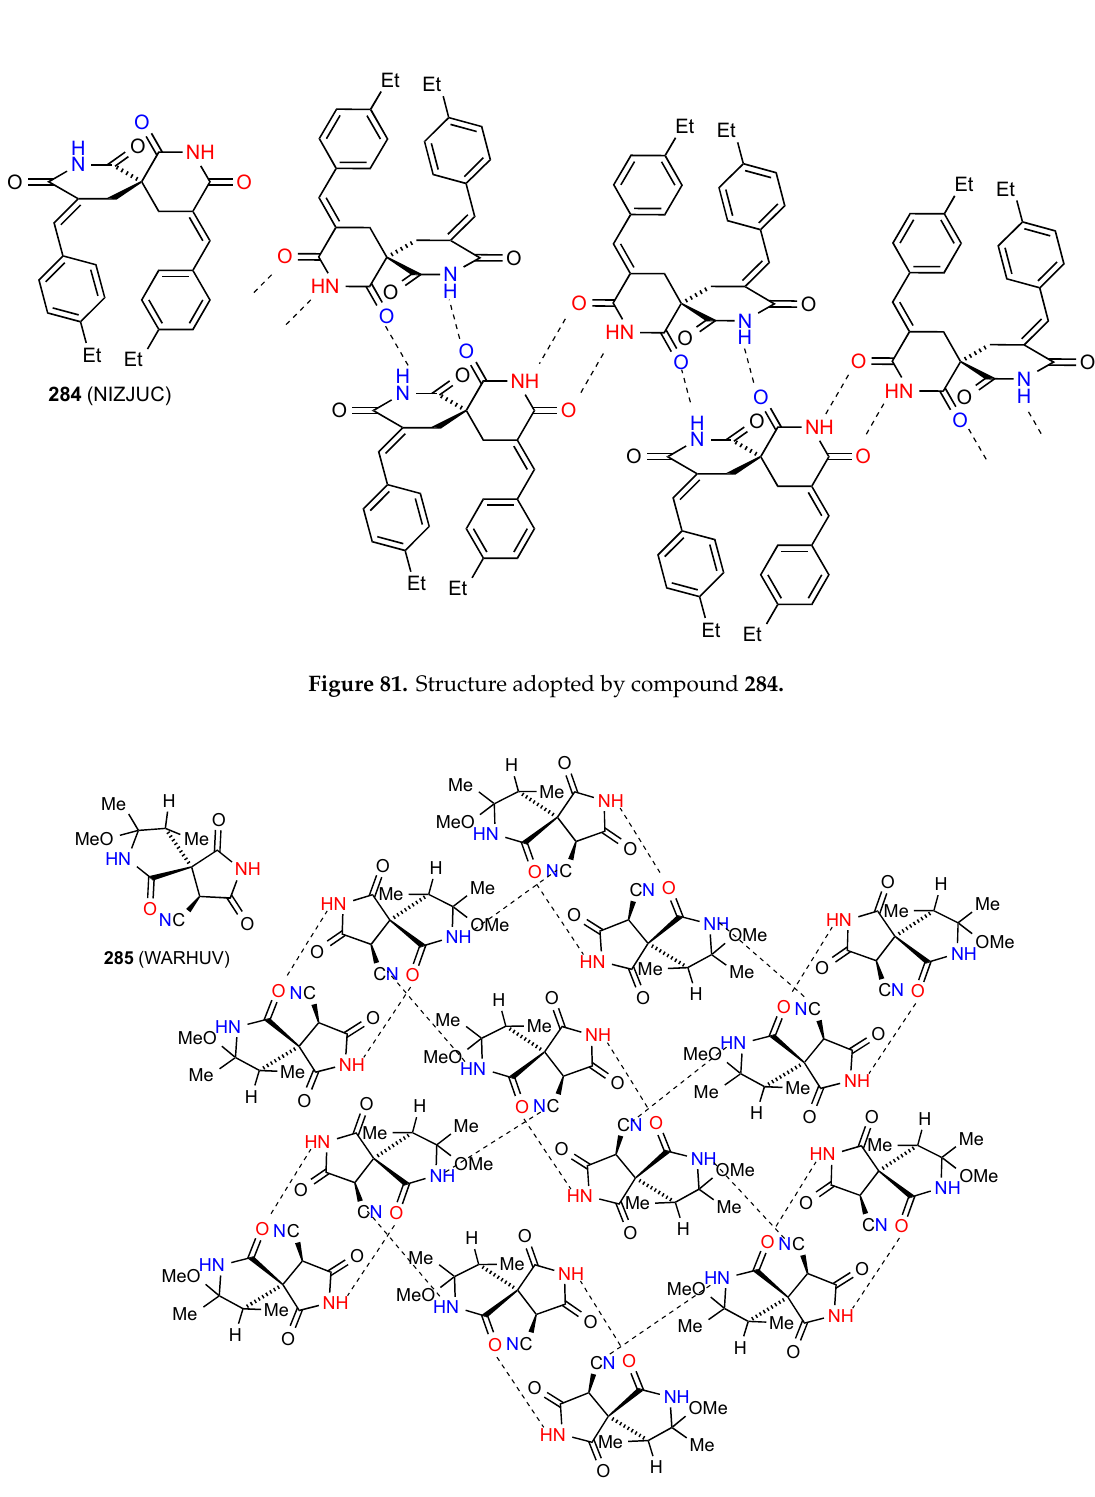
Figure 82. Structure adopted by compound 285.